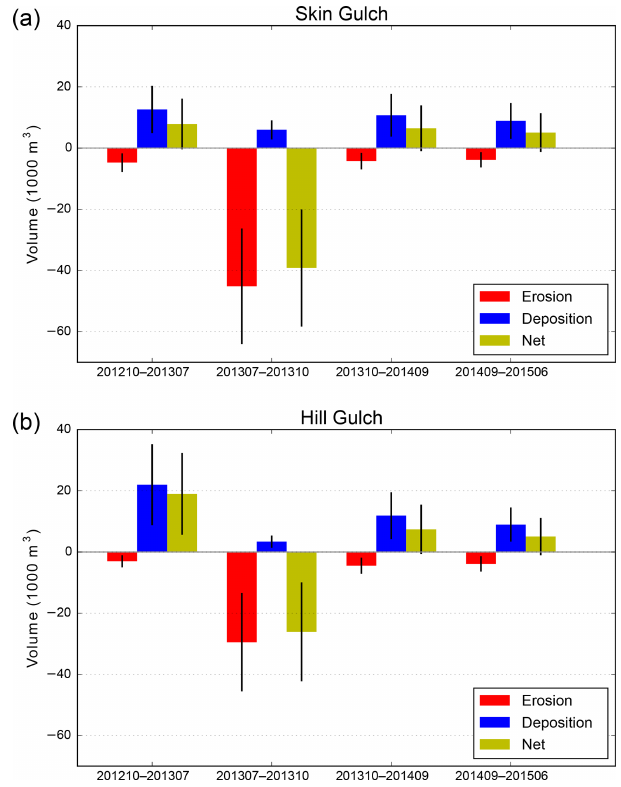
Figure 5. Total valley erosion, deposition, and net volume change for each time period for (a) Skin Gulch and (b) Hill Gulch. Black vertical bars indicate the uncertainty for each volume